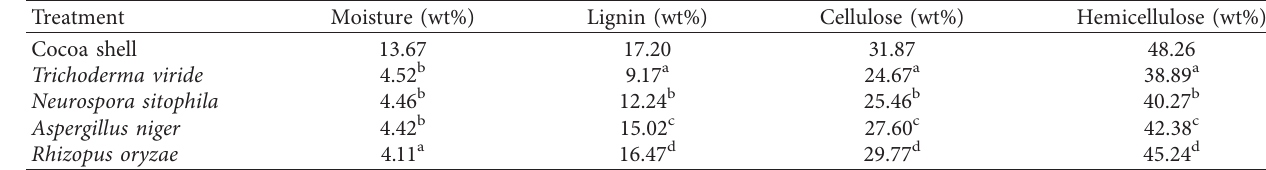
Table 1: Characteristics of cocoa